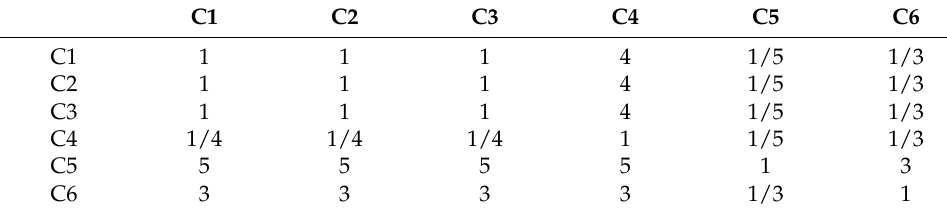
Table 4. Initial assignment of navigation subsystem assessment